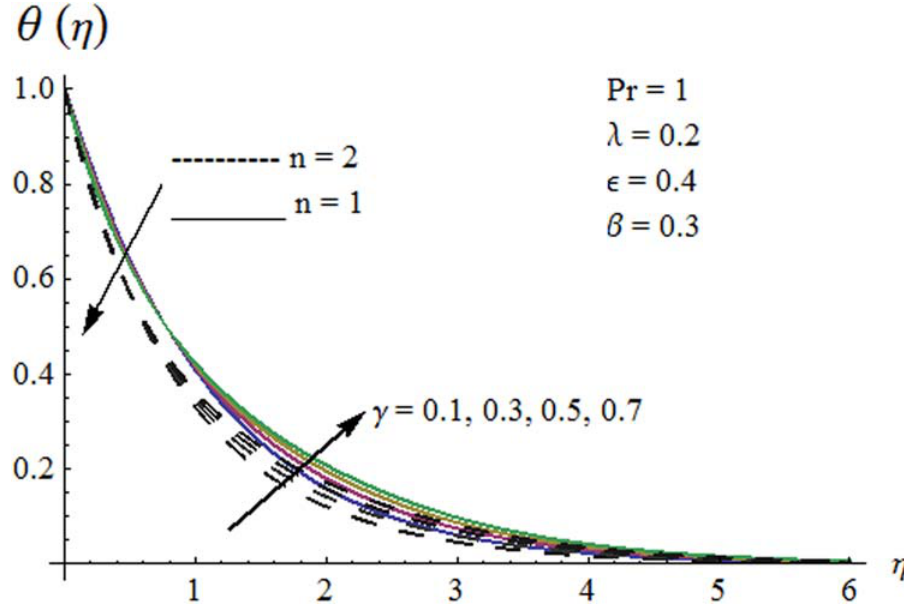
Fig 11. Effect of γ on temperature profile.